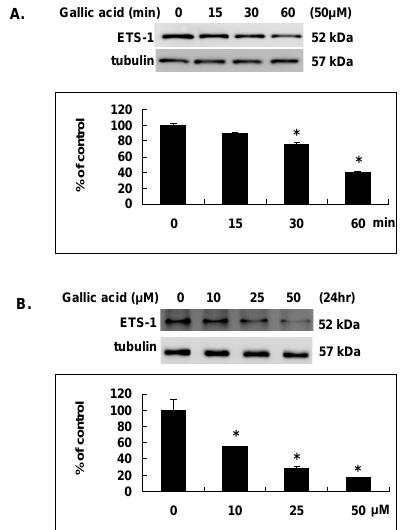
Figure 5. Gallic acid inhibited the Est-1 expression. Gallic acid inhibited the ETS-1 activation in NPC-BM1 cells with time- ( A ) and dose- ( B ) dependent manner by Western blot. Data were representative results from experiments repeated at least three times. * p < 0.05 versus vehicle control. Int. J. Mol. Sci. 2017 , 18 , x FOR PEER REVIEW